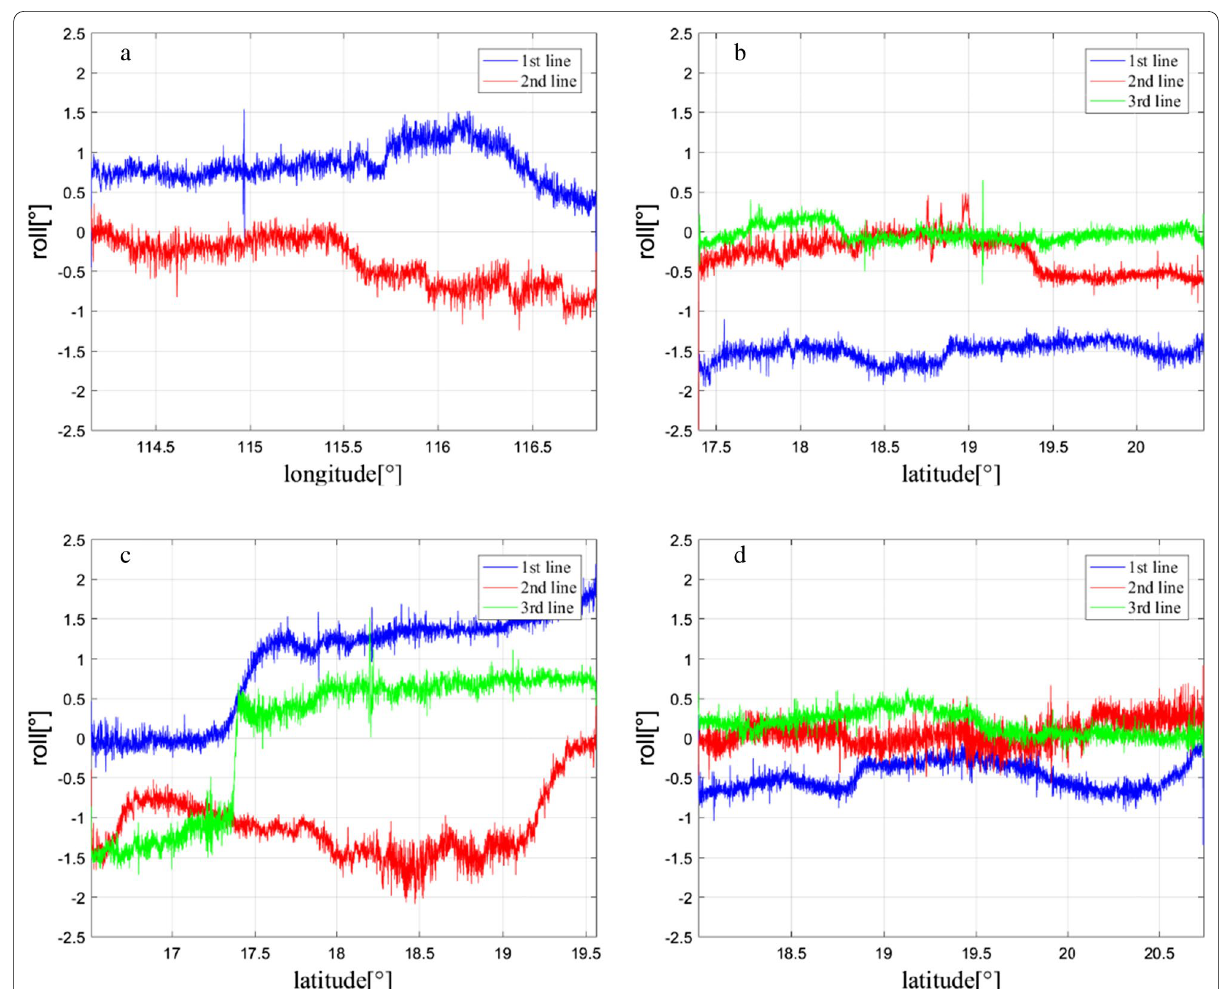
Fig. 5 Roll of each line: a for H1, b for S1, c for X1, and d for X2. For convenience, the roll angle values were filtered by a 40 s FIR